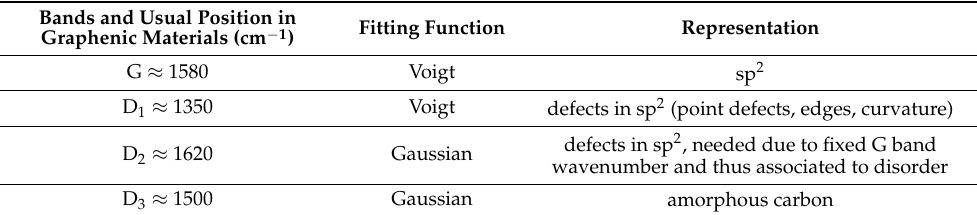
Table 2. Consensual attribution from the literature and corresponding functions that were used for the fitting of Raman spectra with five bands